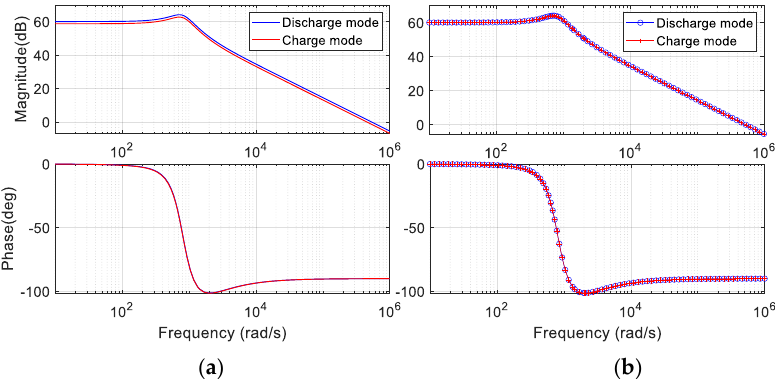
Figure 13. Bode plots of duty ratio-to-inductor current G 21 ( s ) . ( a ) uncompensated charge mode gain; ( b ) compensated charge mode gain.